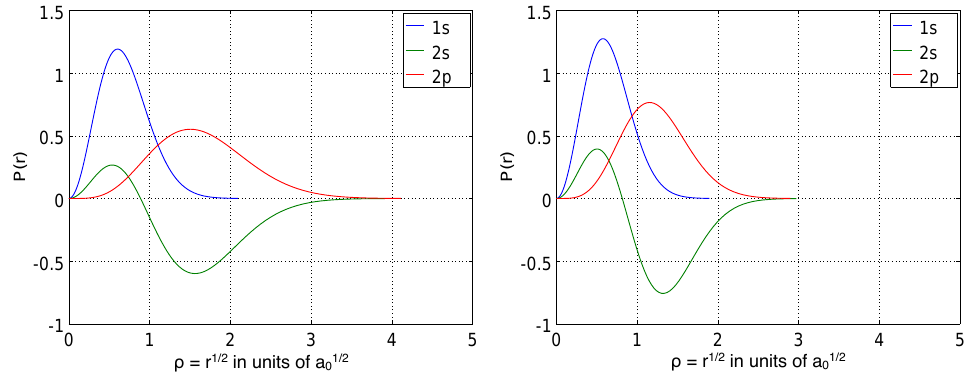
Figure 5. Left : plot of the large components of the 1 s , 2 s and 2 p 3/2 orbitals in Li I as functions √ r , where r is in units of the Bohr radius a 0 , from Thomas-Fermi estimates: Right : large of ρ = components from screened hydrogenic